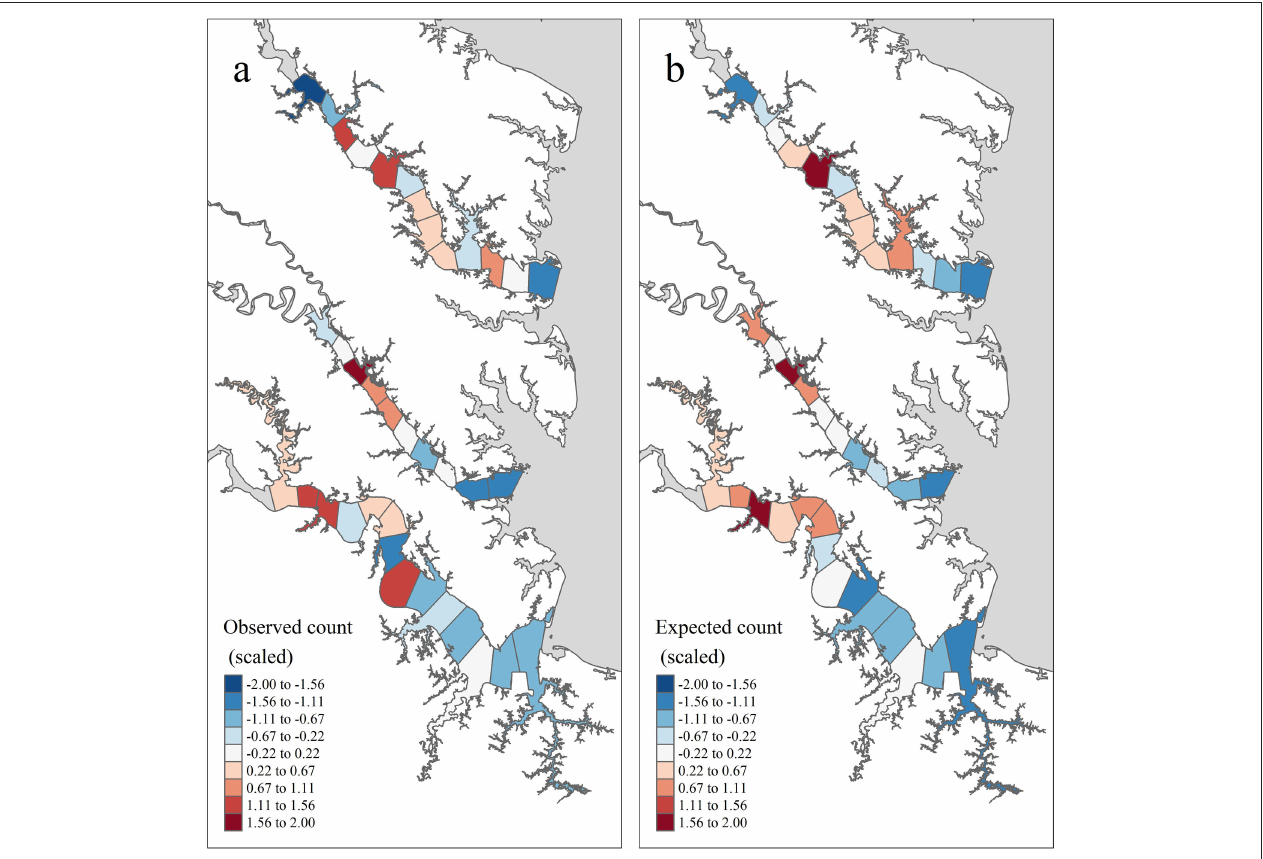
FIGURE 4 | Temporally aggregated observed and expected juvenile blue crab abundance in each tributary section based on inter-annual grand means of model quantities from years 2009–2017 and management after 2008 (see the Methods: Prioritized Areas for Conservation Section for definitions), standardized within tributary. (a) shows the tributary-specific standardized value of y k + (mean observed juvenile blue crab abundance), while (b) shows the tributary-specific standardized value of µ k + (pseudo-posterior median of the expected abundance on the count